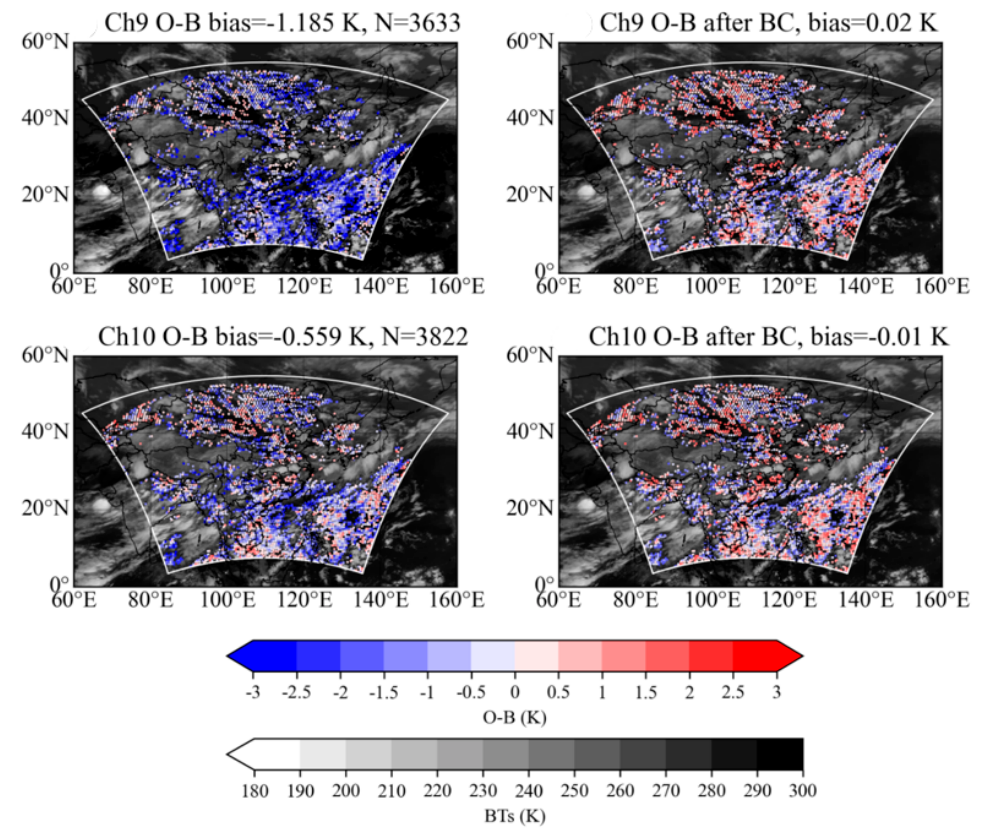
Figure 7. Spatial distributions of the assimilated FY-4A AGRI channel 9 ( upper panel) and channel 10 ( bottom panel) O − B before ( left panel) and after ( right panel) bias corrections, with the 60 km thinning box at 0000 UTC on 5 July 2020. The backgrounds are the brightness temperatures of the AGRI 10.7 μ m IR channel.